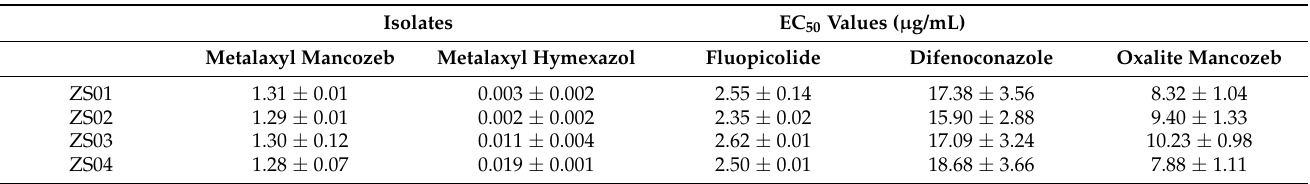
Figure 8. The effect of suppression on isolate ZS01 on plates by corresponding doses of five different fungicides (metalaxyl mancozeb, fluopicolide, oxalite mancozeb, difenoconazole, and metalaxyl hy- mexazol) based on fresh V8-agar medium for 3 days. Table 1. Mean half-maximal effective concentration (EC 50 values) of isolates. (Data = mean ± standard error) .